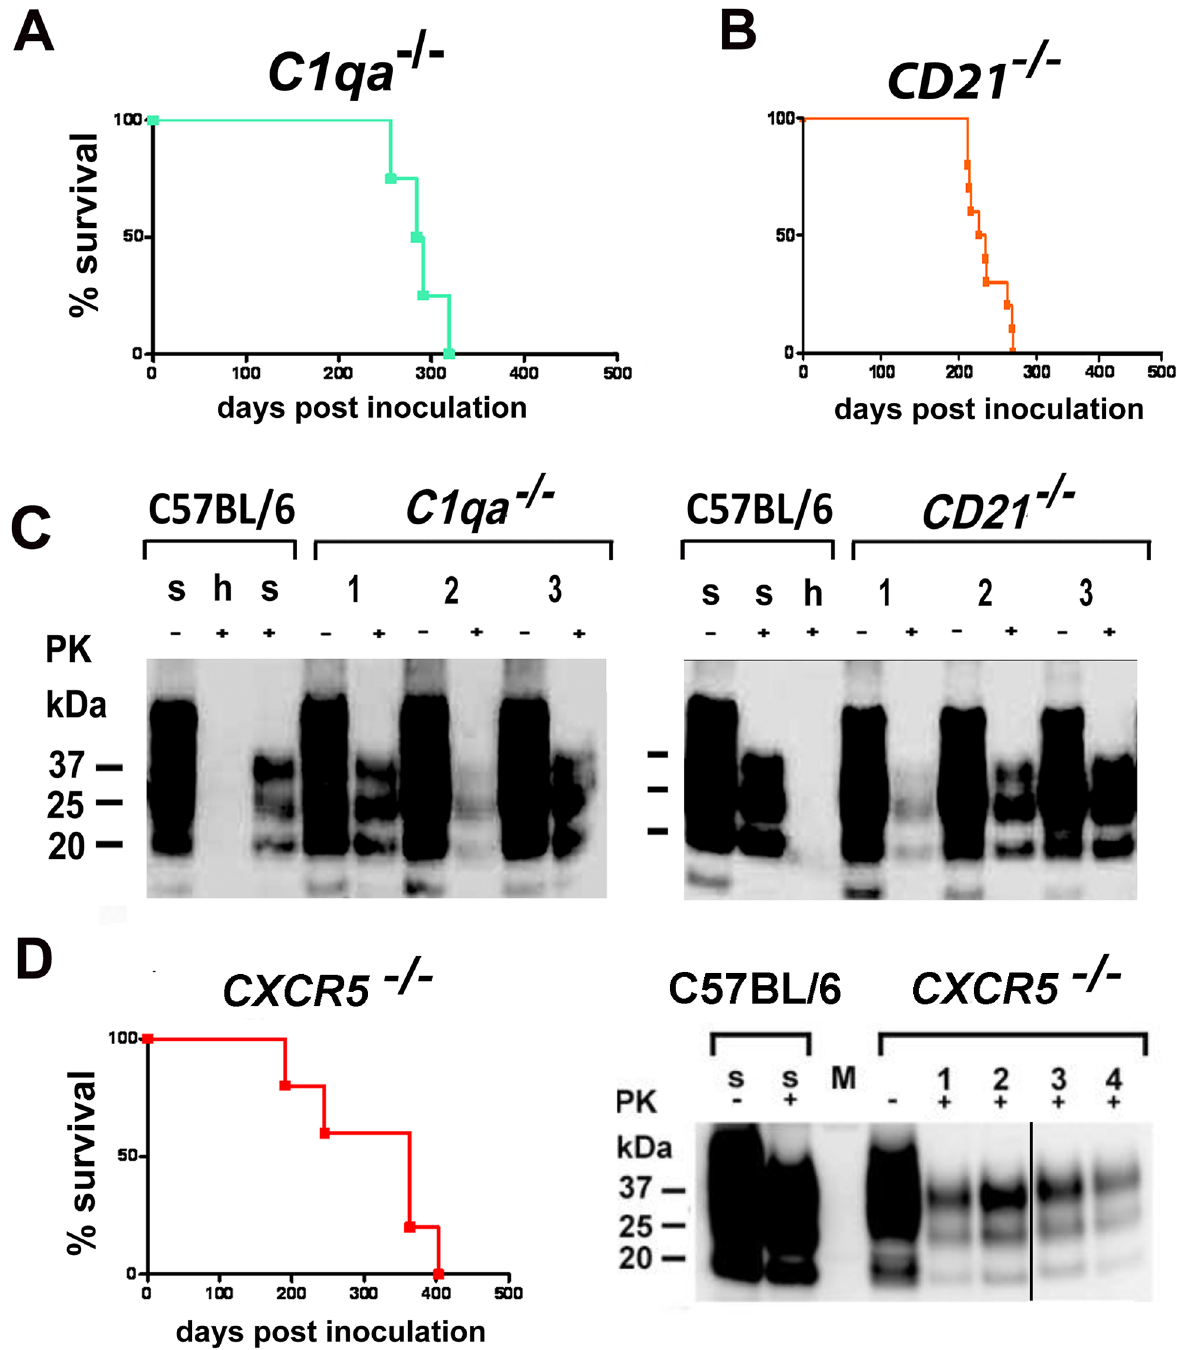
Fig 6. Intranasal prion transmission in immnunodeficient mice. All mice were intranasally inoculated with 3×10 5 LD 50 prions. (A) C1q a − / − mice intranasally inoculated and (B) CD21 − / − mice intranasally inoculated are shown. Survival curves illustrate survival after intranasal prion challenge. Respective Western blots of C1qa − / − mice intranasally inoculated (C, left panel) and of CD21 − / − mice intranasally inoculated (C, right panel) are shown. Survival curves of CXCR5 − / − mice intranasally inoculated are shown (D, left panel). Respective Western blot of CXCR5 − / − mice intranasally inoculated is presented (D, right panel). Brain homogenates were analyzed with (+) and without ( − ) previous proteinase K (PK) treatment as indicated. (D, right panel) Black line indicates crop marks; uncropped blots are shown in S1 File. Controls and legends are as in Fig